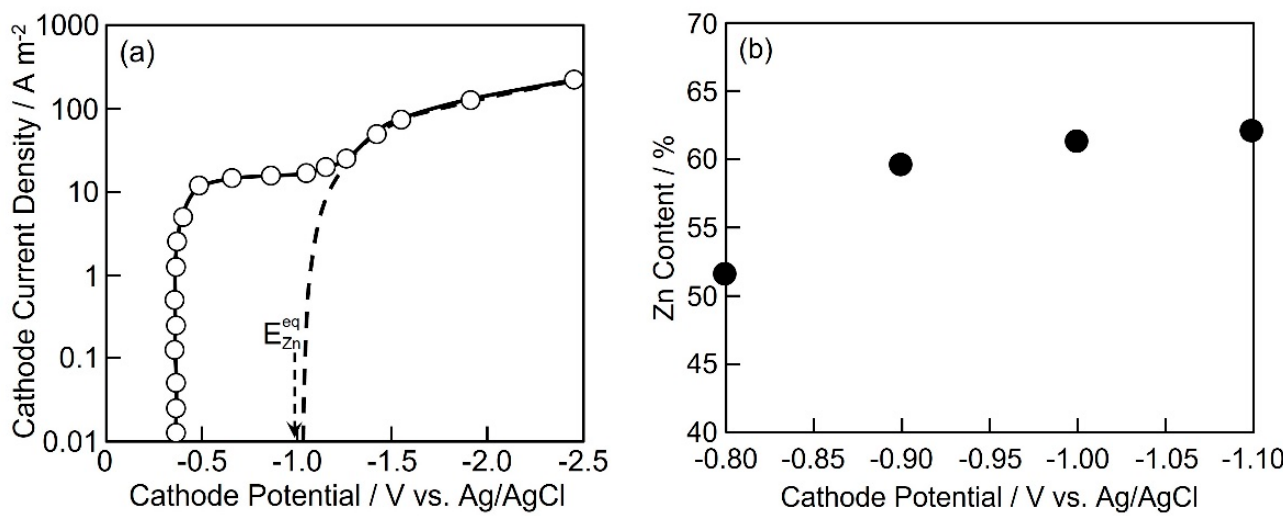
Figure 1. Cathodic polarization curve for the electrodeposition of ZnTe from an aqueous solution containing ZnSO 4 · 7H 2 O (0.1 M), TeO 2 (0.002 M), sodium sulfate (0.5 M), citric acid (0.05 M), and sodium citrate (0.05 M) ( a ). The solution pH and temperature were set to ca. 4.0 and 313 K, respectively. The effect of the cathode potential on Zn content in the electrodeposits was also shown in Figure 1 ( b ).